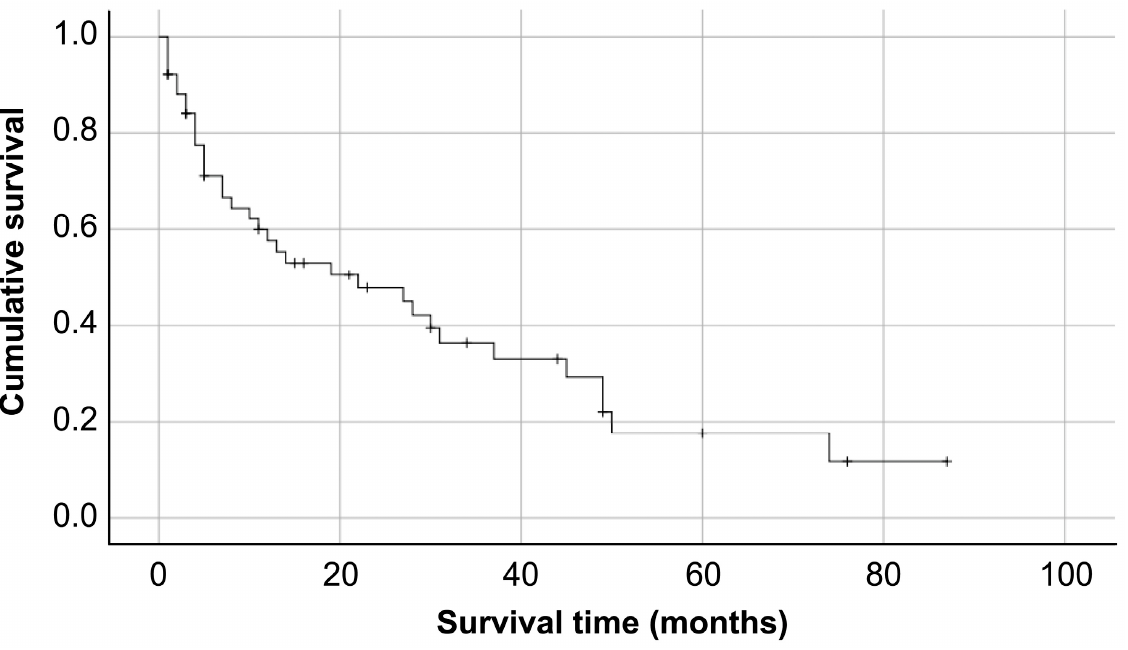
Figure 1. Kaplan–Meier curve for survival in MISt, 22.0 ± 8.6 months (95% confidence interval [CI] 5.1–38.8).